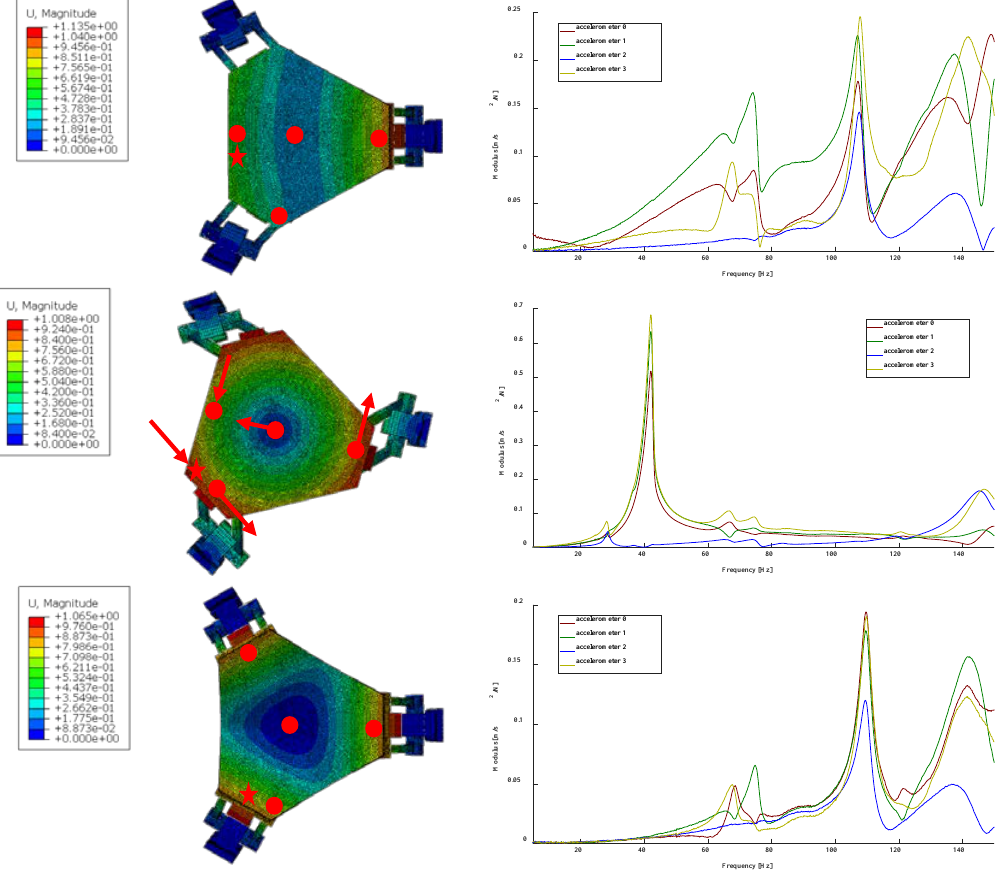
Figure 5. Comparison of the modal analysis results obtained through the Finite Element Method (FEM) and experimentally.